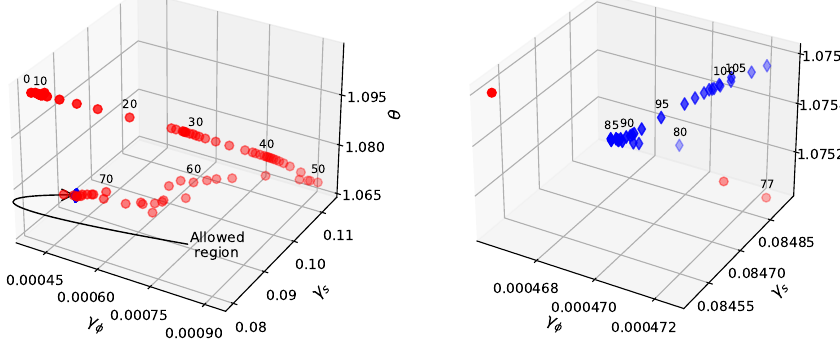
Figure 13: 3D projection of the BFGS run at Λ = 19 for the 4-parameter setup where x = ( ∆ φ , ∆ , ∆ , θ ) . Red points are disallowed, blue diamonds are allowed. Left: s t Full run. The allowed region is located at the tip of the arrow and is barely visible. Points are labelled by their function call number. Right: Zoom in on the allowed